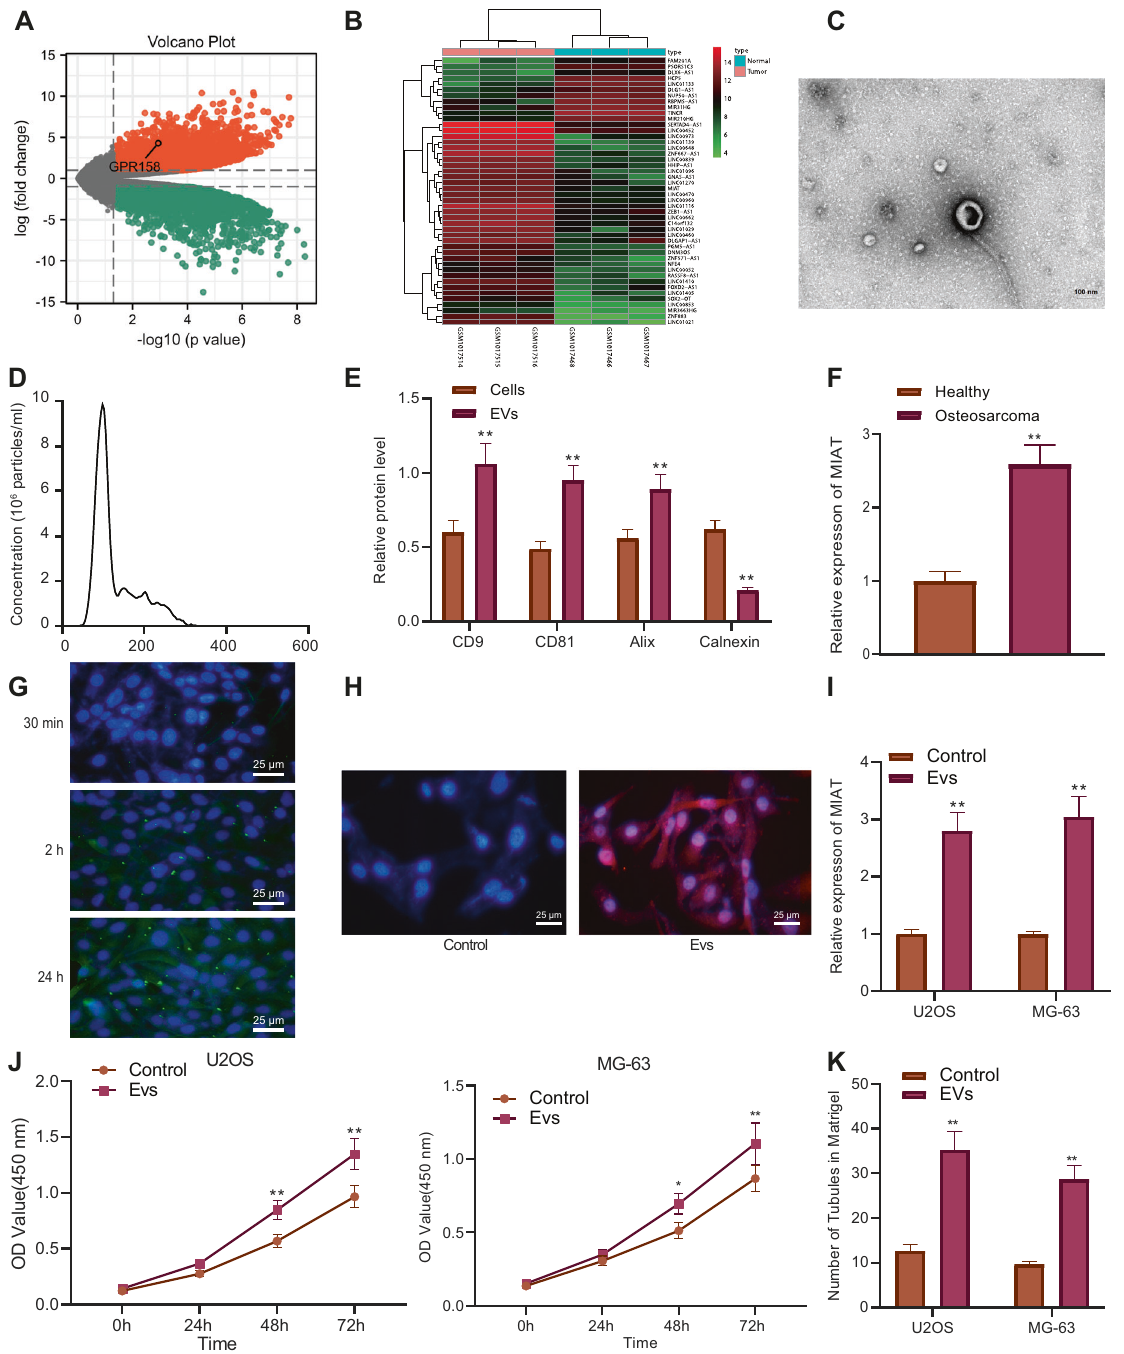
Fig. 2 EV-MIAT enhances osteosarcoma cell proliferation and angiogenesis. A A volcano plot of differentially expressed mRNAs in osteosarcoma samples from the GSE41445 dataset. The abscissa represents − log10 ( p value), the ordinate represents logFC, the red dots indicate signi fi cantly upregulated genes and the green dots indicate signi fi cantly downregulated genes in osteosarcoma samples. B A heat map of differentially expressed lncRNAs in osteosarcoma samples from the GSE41445 dataset. The abscissa represents the sample number and the ordinate represents the lncRNA; the left dendrogram refers to the lncRNA expression cluster and the histogram at the upper right refers to a color gradation; each small square in the fi gure represents the expression of a lncRNA in a sample. C Morphological characterization of the serum-EVs observed using a TEM. Scale bar = 100 nm. D The size distribution of EVs analyzed by NTA. E Western blot analysis of CD9, CD81, Alix, and Calnexin proteins in osteosarcoma cells and the isolated EVs. F MIAT expression was determined by RT-qPCR in the serum-EVs from healthy individuals and osteosarcoma patients ( n = 68). G Internalization of EVs by MG63 cells observed under a fl uorescence microscope (PKH67-labeled EVs show green fl uorescence and DAPI-labeled nucleus show blue fl uorescence) (scale bar: 25 μ m). H Immuno fl uorescence analysis of Flag-labeled MIAT in MG63 cells following incubation with EVs (Flag-labeled MIAT shows red fl uorescence and DAPI-labeled nucleus shows blue fl uorescence) (scale bar: 25 μ m). I MIAT expression was determined by RT-qPCR in U2OS and MG63 cells incubated with EV-MIAT. J Proliferation of EV-treated U2OS and MG63 cells measured by CCK-8 assay. K Angiogenesis of EV-treated U2OS and MG63 cells measured by microtubule formation in vitro. * p < 0.05, ** p < 0.01. All experiments were conducted three times